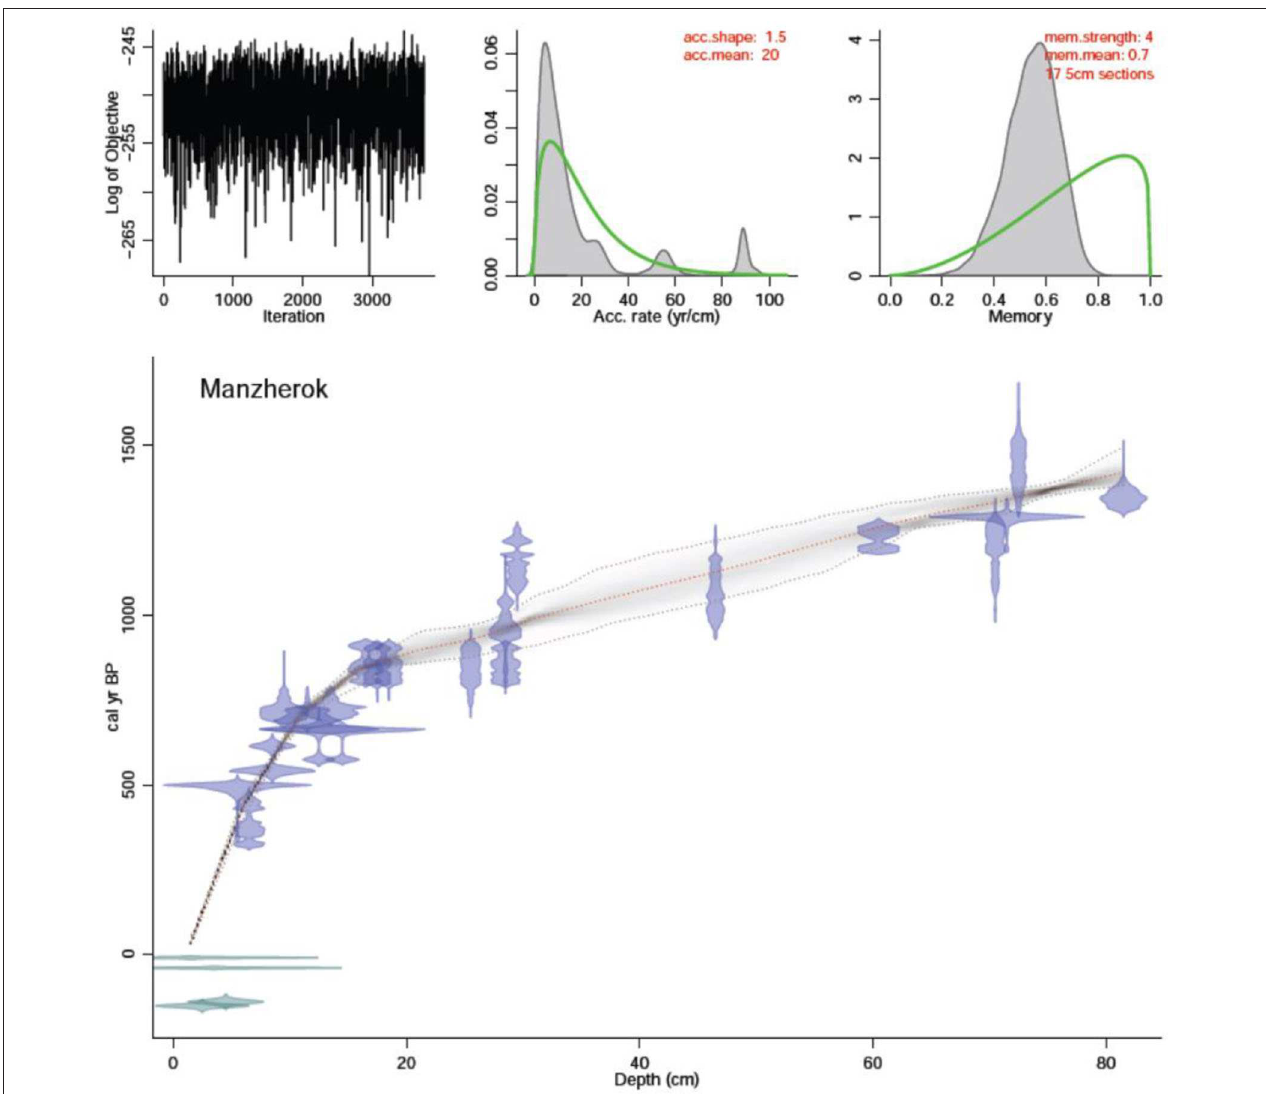
FIGURE 4 | Bacon model result (see text for evaluation of the